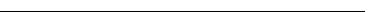
Table 2. Correlation between the winter Barents–Kara sea precipitation anomalies and winter arctic atmospheric circulation. Correlation coefficients over 90%, 95%, and 99% confidence levels are represented by *, ** and ***, respectively. NAO AO SH R